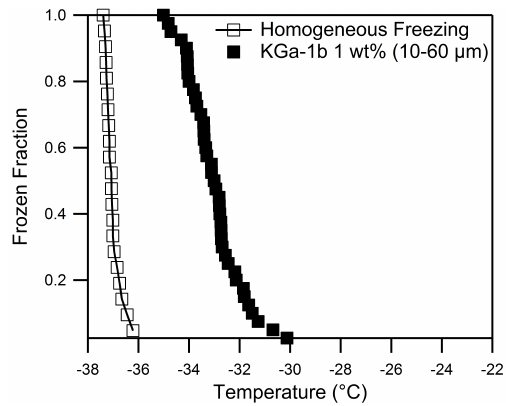
Figure 5. Frozen fraction curve for 1wt% KGa-1b in 10–60µm droplets as a function of temperature. Also shown are results for freezing of ultra-pure water droplets (homogeneous